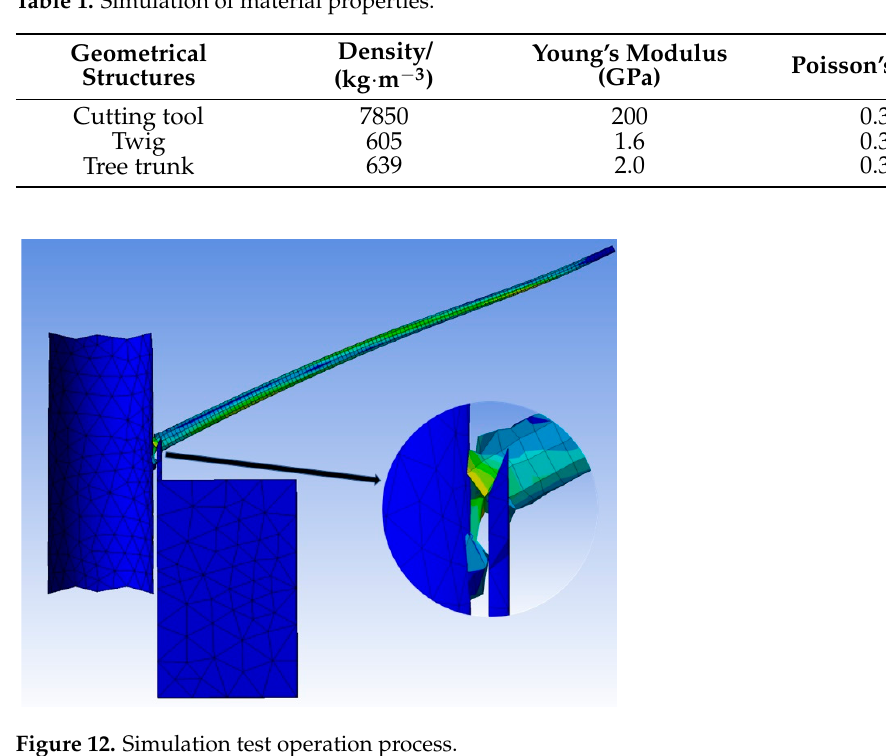
Figure 12. Simulation test operation process.